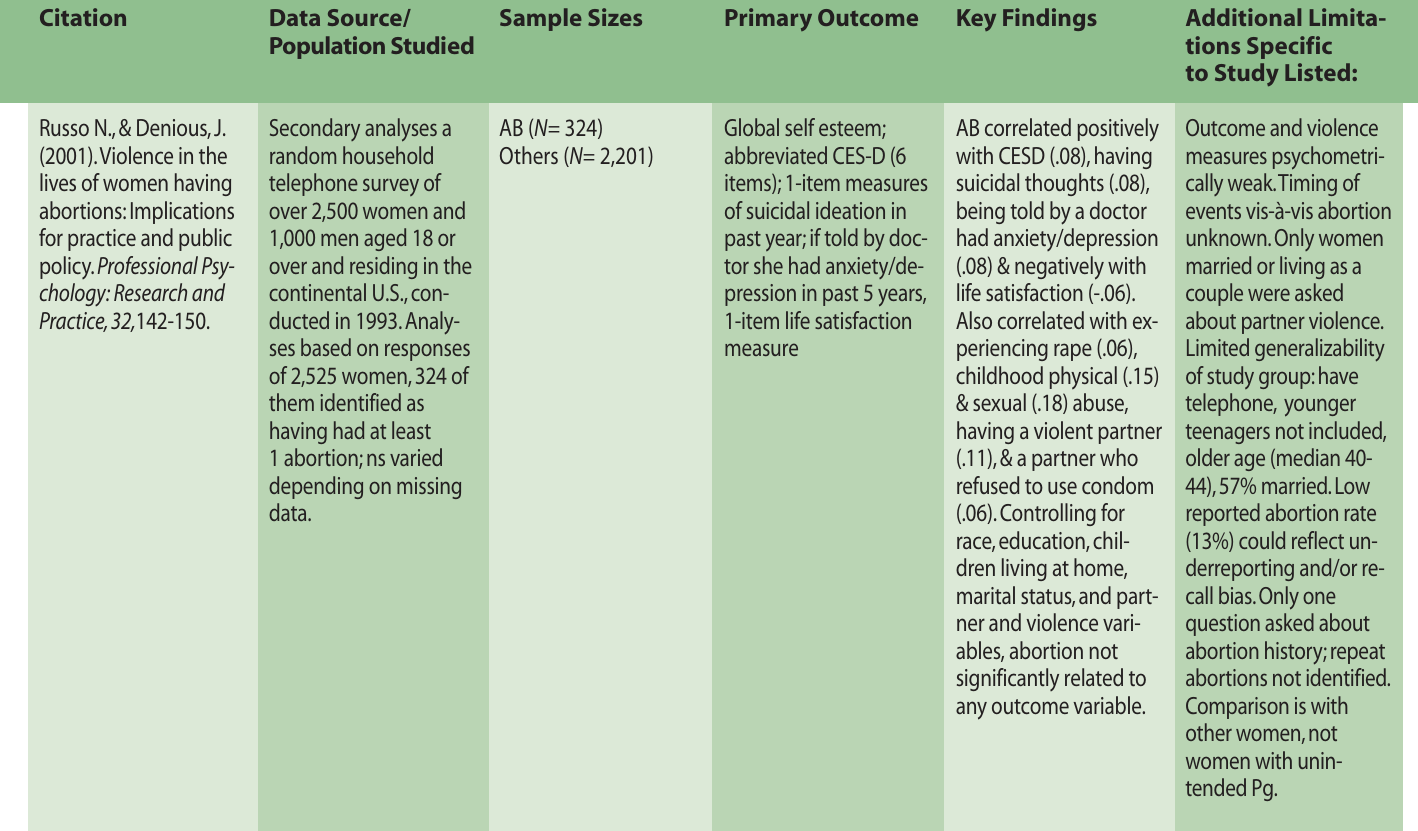
Table 1B: Secondary Analyses of Survey Data–Abortion vs.Comparison